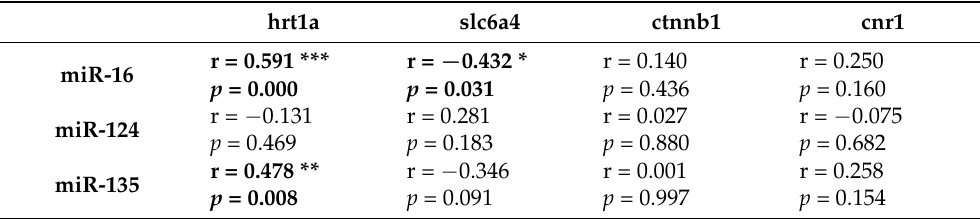
Table 2. Pearson correlation coefficients between miRNA levels and genes in the vmPFC in rats exposed to UCMS and CBD. hrt1a